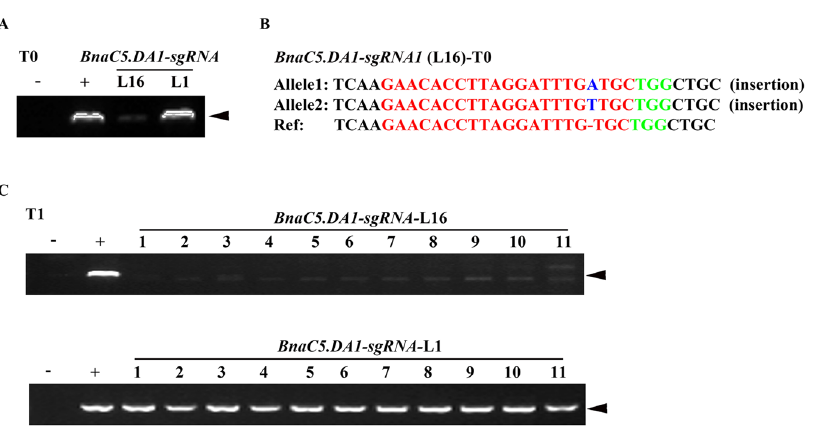
Figure 2. Genotyping of the BnaC5 . DA1-sgRNA -L16 plants in the T0 and T1 generation. ( A ) Cropped gel image showing the PCR products derived from Cas9 in BnaC5 . DA1-sgRNA - L16 in the T0 generation. ( B ) The genotype of BnaC5 . DA1-sgRNA - L16 in the T0 generation. The PAM sequence is indicated with green. The sgRNA is indicated with red. Mutation sites are indicated with blue. ( C ) Cropped gel image showing the PCR products of Cas9 in different progeny from BnaC5 . DA1-sgRNA - L16 in the T1 generation. + : pKSE401 was used as a positive control; − : gDNA of WT was used as a negative control. BnaC5 . DA1-sgRNA-L1 (T0 and T1) was used as a positive control for the Cas9 insertion. The arrowheads indicate the position of the